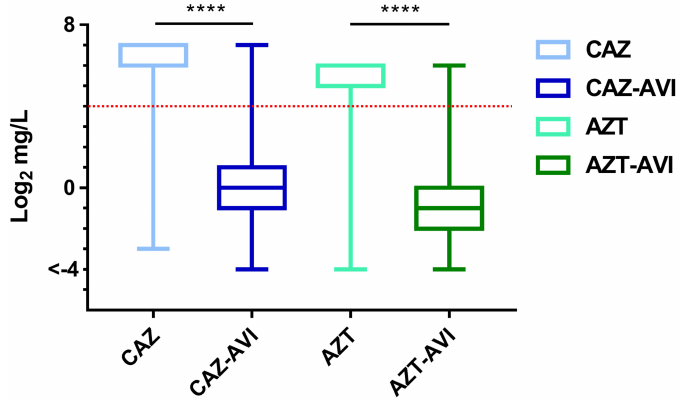
Figure 2. MIC distribution box plots for the four regimens tested in this study. Red dotted line indicates resistance breakpoints for each agent according to CLSI guidelines. From top to bottom, horizontal lines indicate maximum, third quartile (Q3, 75%), medium (50%), first quartile (Q1, 25%), and minimum MIC values. Abbreviations: CAZ, ceftazidime; CAZ-AVI, ceftazidime with avibactam; AZT, aztreonam; AZT-AVI, aztreonam with avibactam. ****, p < 0.0001.